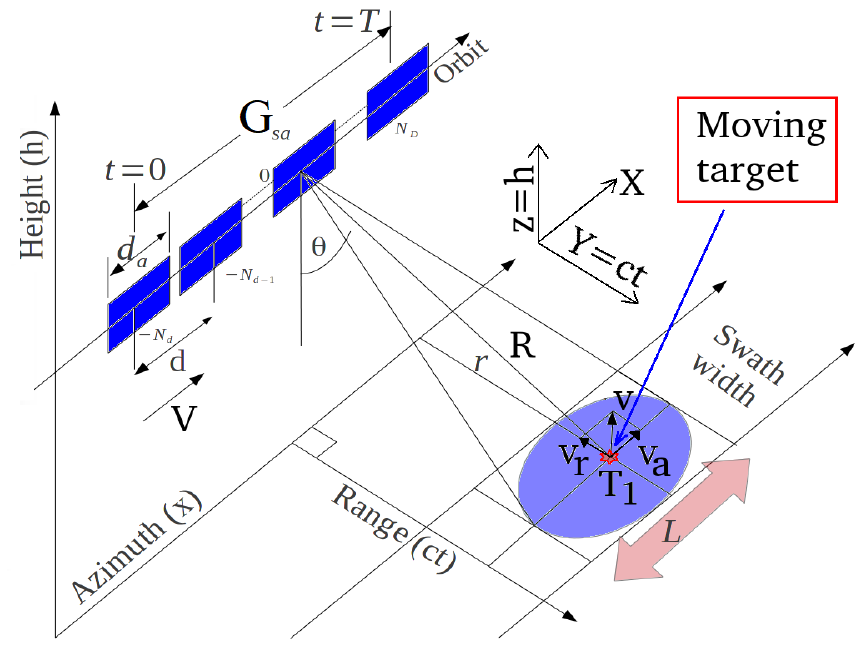
Figure 1. SAR acquisition